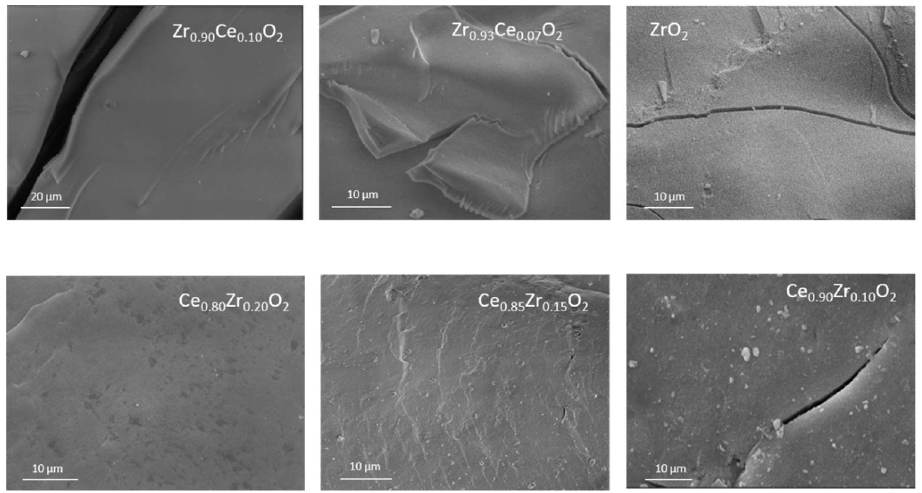
Figure 3. SEM images of selected supports.